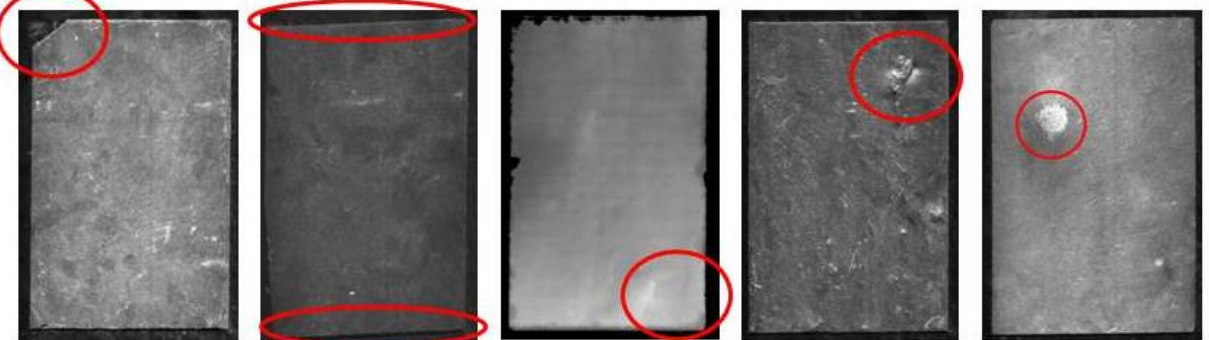
Figure 1. Defects identified. Left to right: material defects, false squaring, warping, fissuring and white staining.